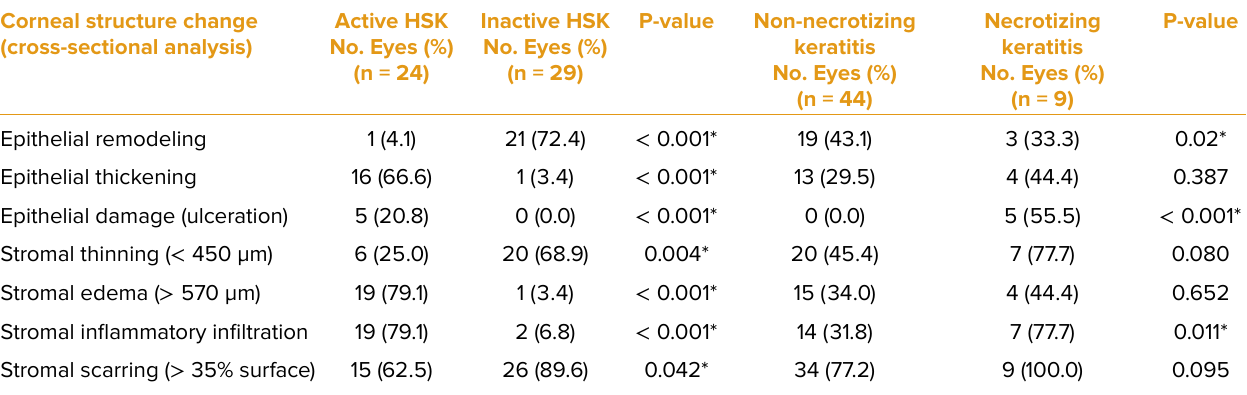
Table 1. Frequency of SD-OCT morphologic changes of herpetic stromal keratitis according to inflammatory status and type of keratitis.